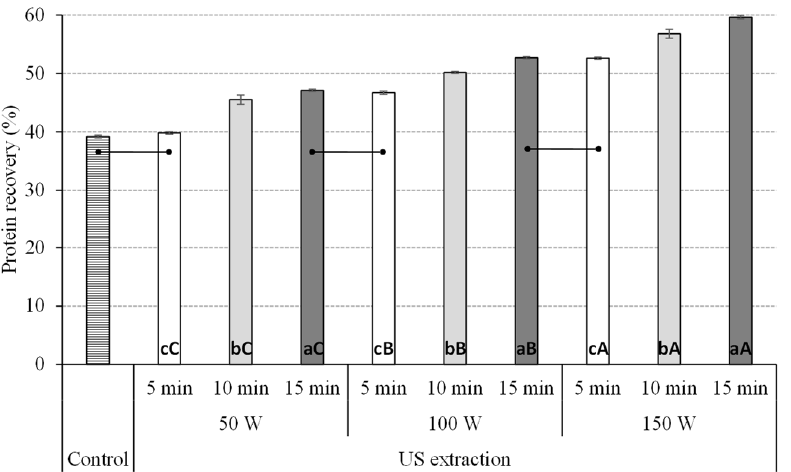
Figure 1. Effect of extraction conditions time (5, 10 and 15 min) and ultrasonic (US) power (50, 10 and 150 W) on the protein recovery from giant kelp. Data are presented as average ± standard deviation ( n = 3). Bars inside the figure indicate extraction conditions showing no statistical differences in terms of protein recovery for all the extraction conditions tested. Different lowercase letters represent statistical differences ( p < 0.05) in protein recovery at different times of extraction using the same ultrasound (US) power, while different uppercase letters represent statistical differences ( p < 0.05) in protein recovery at different US power using the same extraction time.